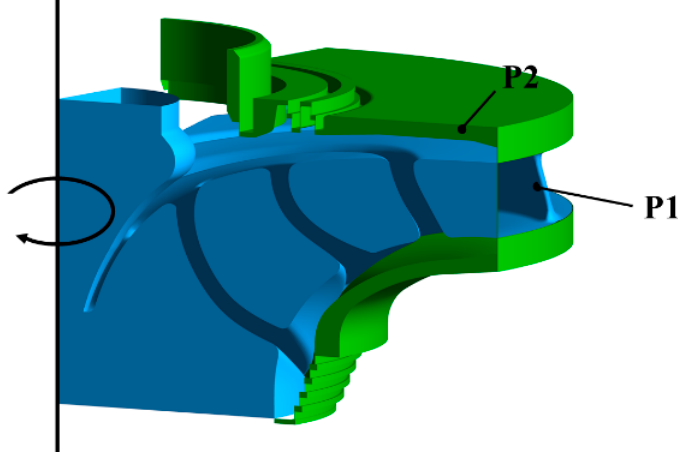
Figure 19. The pressure fluctuation measure points (P1 is the pressure fluctuation recording point in runner; P2 is the pressure fluctuation recording point in clearance).